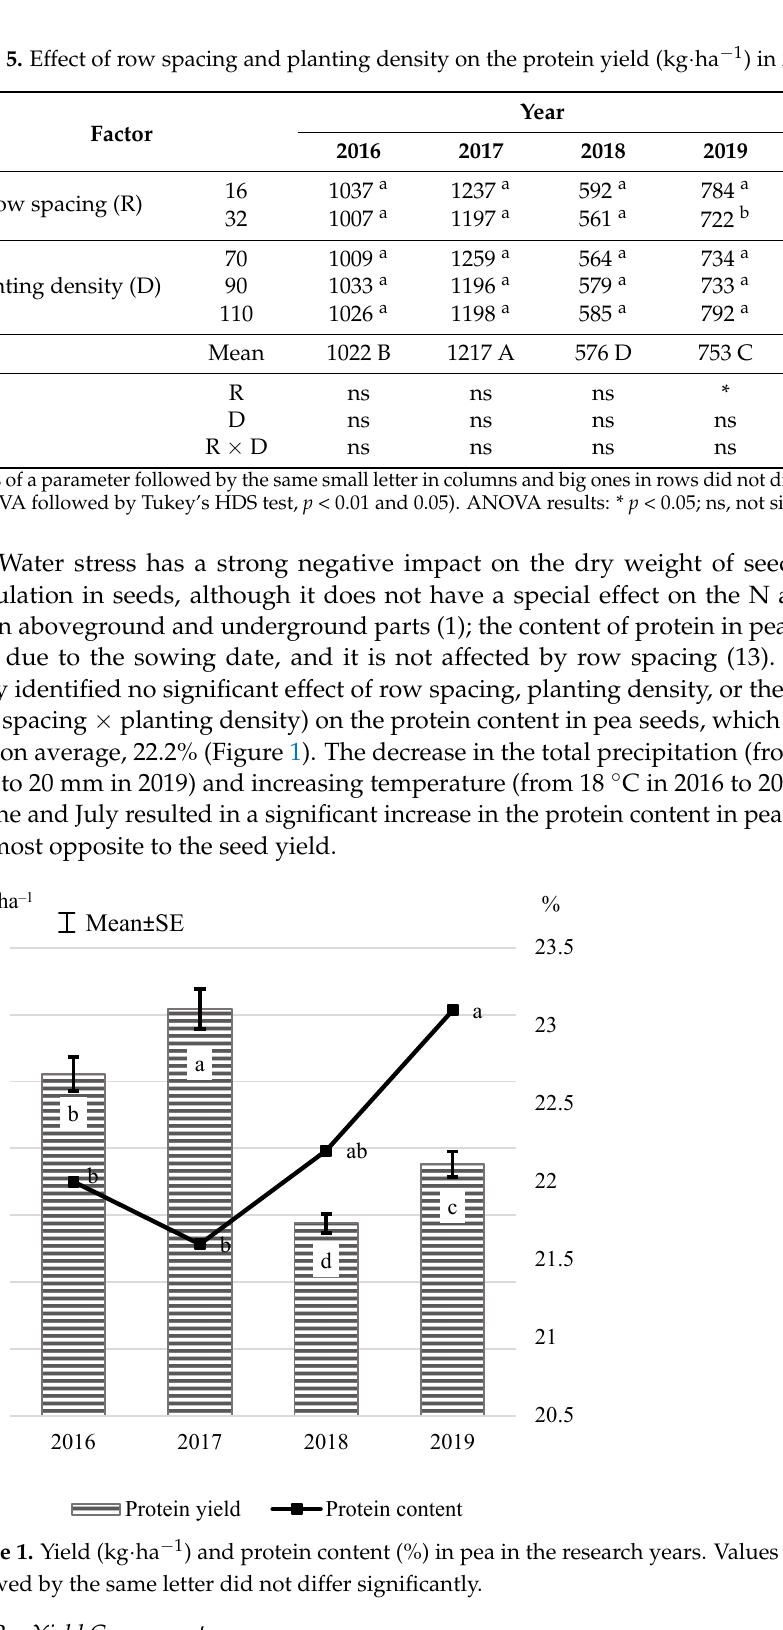
Table 5. Effect of row spacing and planting density on the protein yield (kg ∙ ha − 1 ) in 2016–2019. Factor